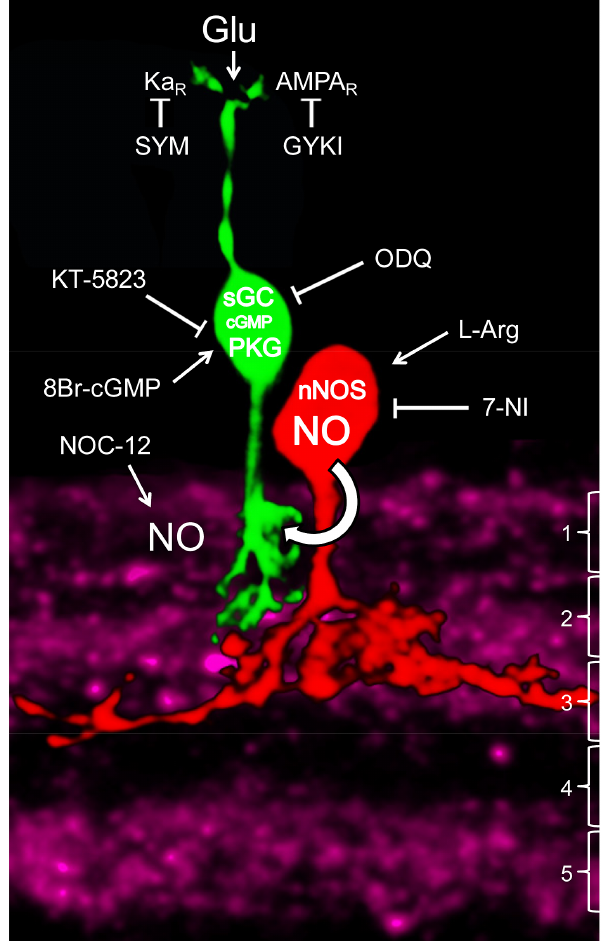
Figure 6. Scheme of proposed NO signaling onto type 4 OFF CBCs in the inner retina. The profiles of a nNOS-positive NOAC (red) and a type 4 OFF CBC (green) are projected onto the nNOS-labeled IPL (purple). The substrata of the IPL are indicated to the right. nNOS is most concentrated in the substrata 2–3 and 5 and largely absent from substratum 4. NOACs mainly ramify in sublayer 3 of the IPL [7]. Glutamate (Glu) from cones or exogenous stimulation activates kainate and AMPA receptors (Ka R and AMPA R ), whose responses can be blocked by SYM-2081 (SYM) and GYKI-52466 (GYKI), respectively. NO, liberated by NOACs or the NO donor NOC-12, diffuses into CBCs, activating sGC, leading to cGMP elevation which stimulates protein kinase G (PKG). This pathway can be emulated by 8Br-cGMP application and inhibited by ODQ or KT-5823. Endogenous NO synthesis is stimulated by L-arginine and inhibited by 7-NI. The mechanism by which the AMPA-dependent glutamate response is inhibited via PKG remains to be